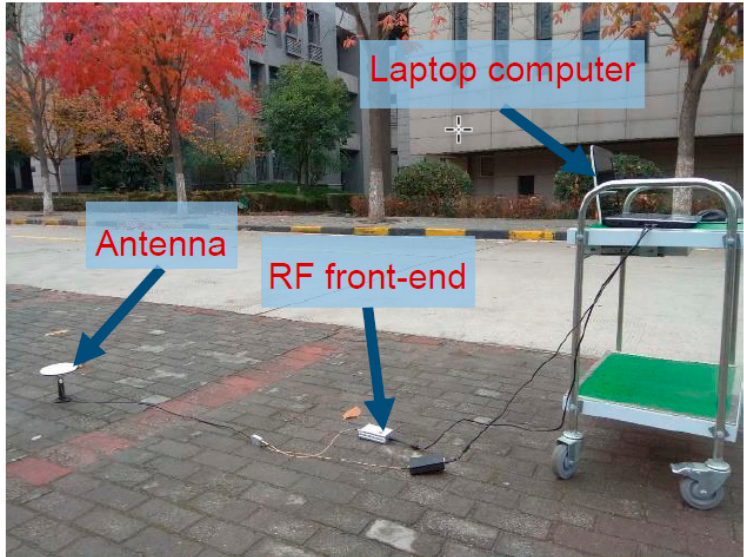
Figure 9. Static real signal acquisition environment.